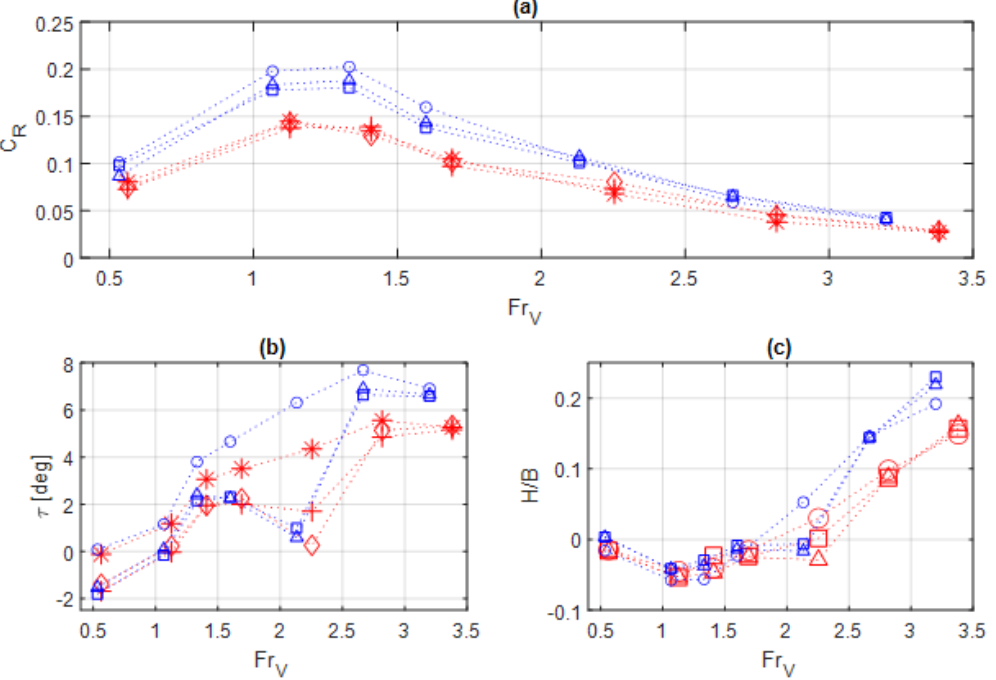
Figure 13. Steady-state results for hulls with LCG = 45%: ( a ) resistance coefficient, ( b ) trim, ( c ) normalized CG rise. Circles and stars, constant-deadrise hull; squares and crosses, concave hull; triangles and diamonds, convex hull. Red larger symbols, nominal-weight condition ( C B = 0.912); blue smaller symbols, overloaded ( C B = 1.276).